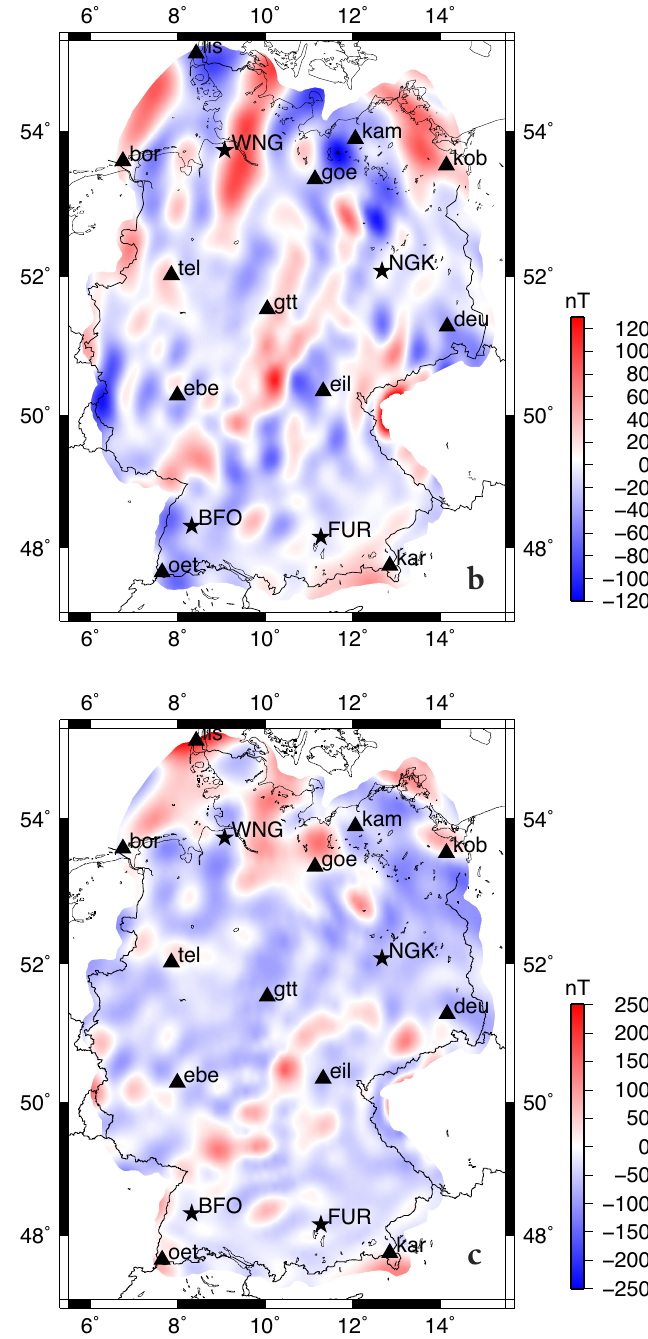
Figure 1. Magnetic observatories (stars) and first order repeat stations (triangles) in Germany, shown on the lithospheric magnetic anomaly maps for a) the North (X), b) the East (Y) and c) the vertical component (Z) obtained from the regional model by Korte and Thébault